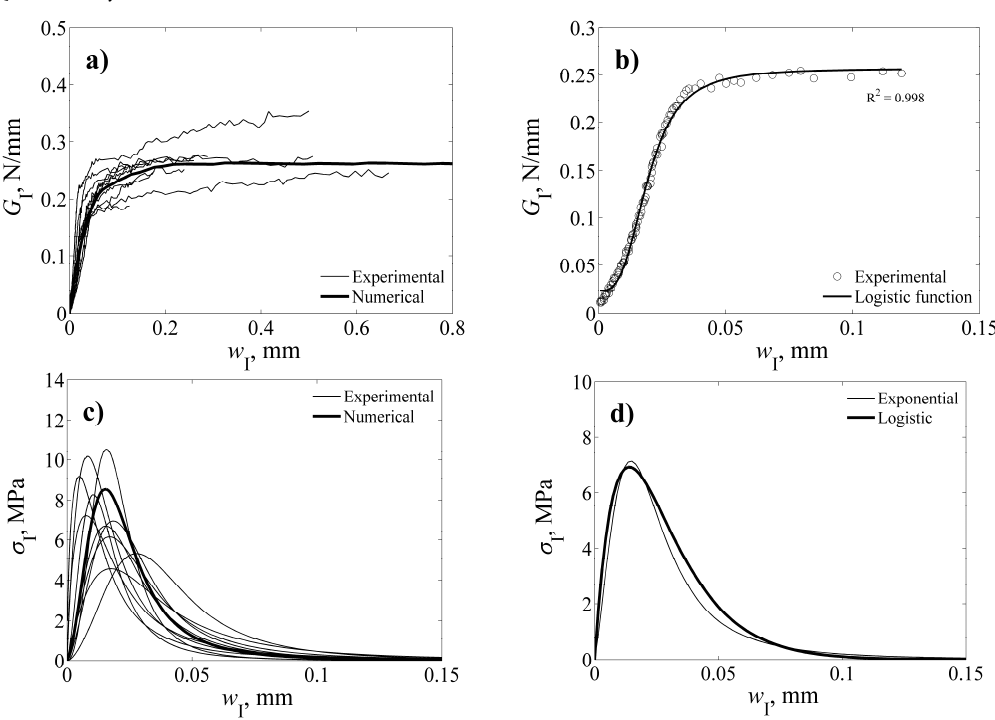
Figure 5: DCB test processed by Irwin-Kies equation: (a) characteristic R –curves logistic function; (c) cohesive laws in mode I